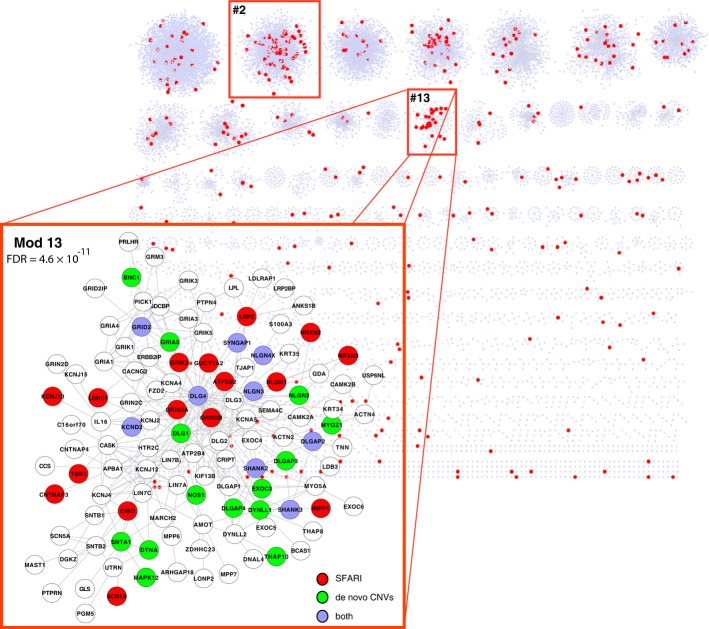
A modular protein interaction network with modules containing enrichment of autism-associated genesTwo topological modules (#2 and #13) on human protein interaction network showed significant enrichment for autism genes (in red). The topological modules are physical clusters on the network where their member genes intensively interact with each other but sparsely interact with non-member genes on the network. A zoom-in view of module #13 is also shown, where known autism genes and genes affected by ASD-associated de novo CNVs were colorized in red and green, respectively. Genes annotated by both were in blue. The false discovery rate indicates its significant enrichment for the known autism genes.